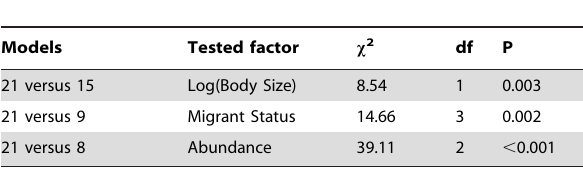
Table 2. Analysis of deviance between the best and candidate model, testing for significance of the effect of Log(Body Size), Migrant Status and Abundance on the probability of apparent local extinction of bird species in the studied region of China. Each model is fully described in Table 1.